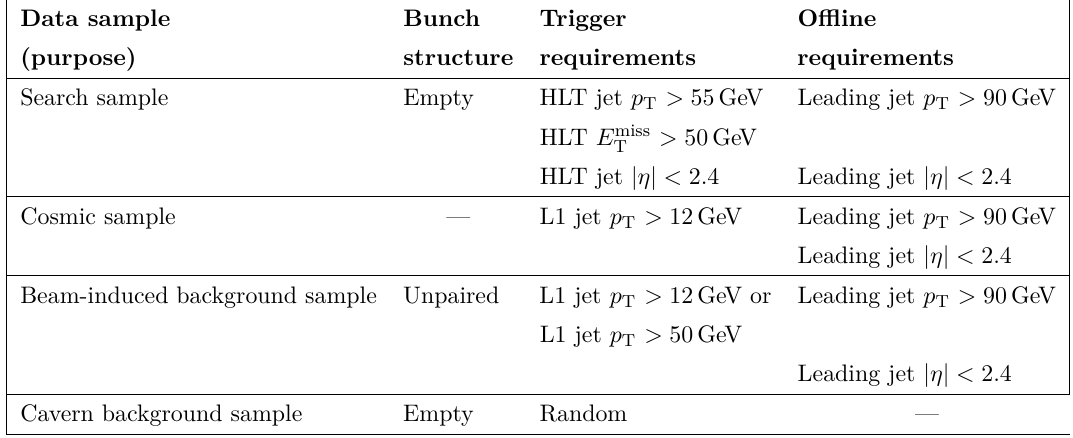
Table 1 . Overview of the data samples used in this analysis. The kinematic requirements at the HLT or L1 trigger that events are required to pass in order to be recorded are indicated under ‘trigger requirements’, with the corresponding requirements enforced at analysis level indicated under ‘offline requirements’. No ‘bunch structure’ is listed for the cosmic sample, since no beam was circulating in the LHC machine while these cosmic data were being